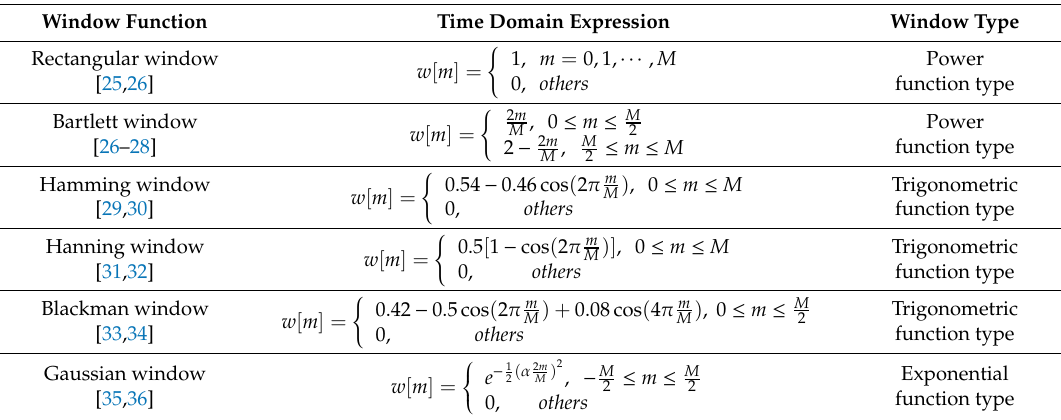
Table 1. Several common window